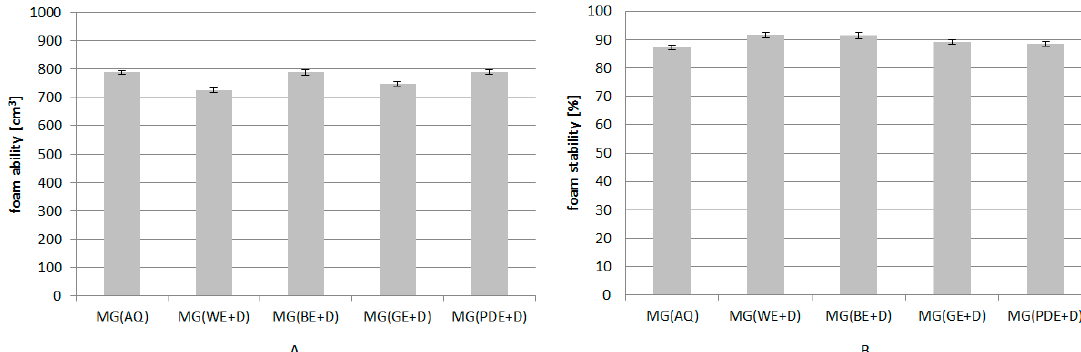
Figure 7. Foam ability ( A ) and foam stability ( B ) of model wash gels, where: MG(AQ)—model gel containing water in place of extract, MG(WE+D), MG(BE+D), MG(GE+D), MG(PDE+D)—model gels containing 10% ( w / w ) of appropriate extracts. The final result was the arithmetic mean of five independent measurements.